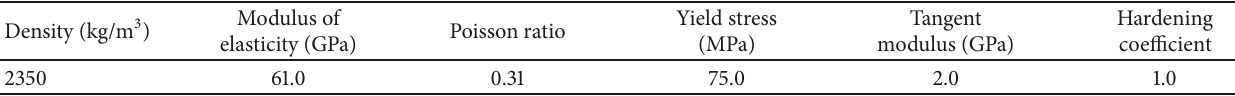
Figure 9: Numerical simulation models. Table 4: Material model and state equation parameters of the rock.